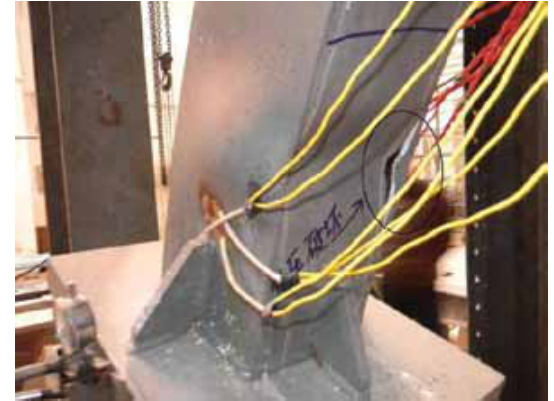
Fig. 9. Failure of ZHJD-2 compressive web member P = 3500 kN a)